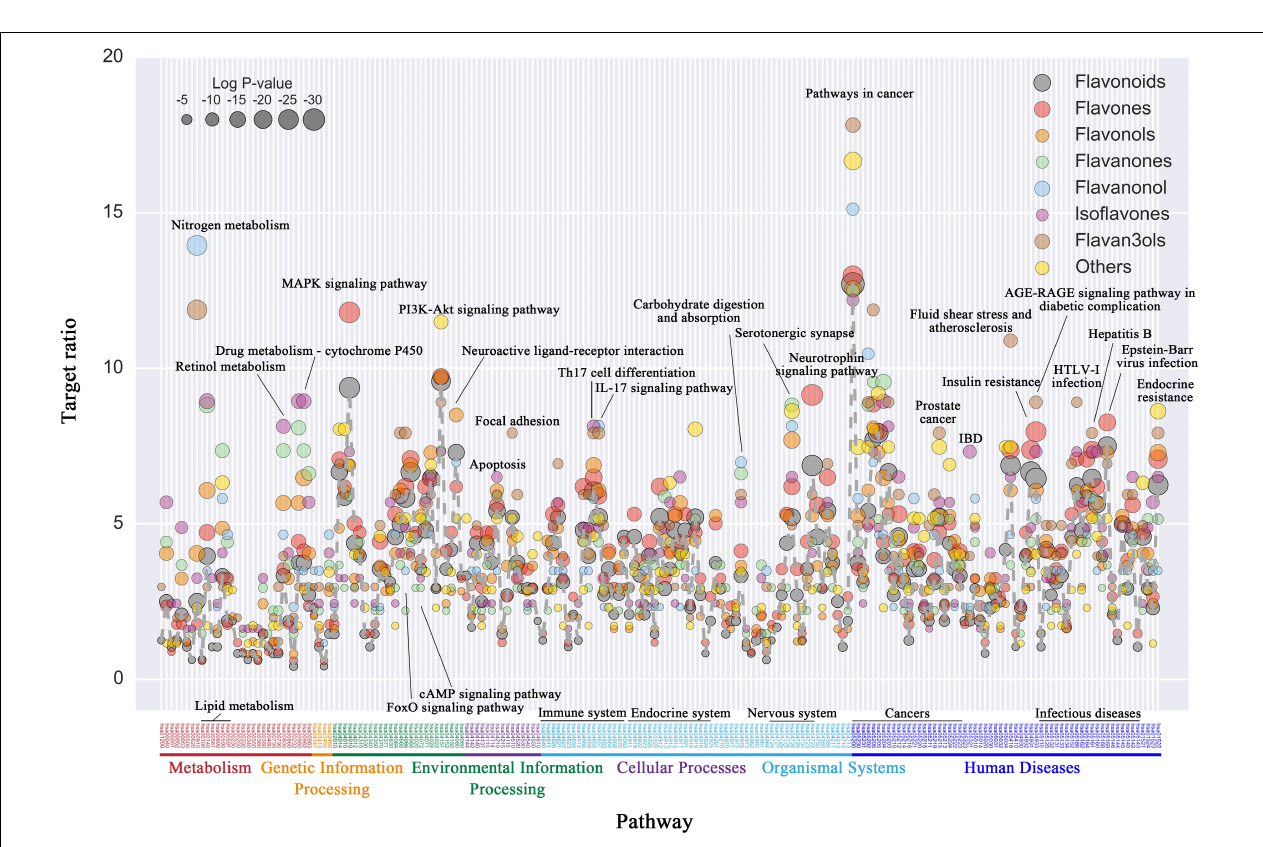
FIGURE 2 | KEGG pathway enrichment analysis of natural flavonoid products’ targets. Here, X -axis represents the enriched pathways ( p -value < 0.05), which were categorized according to KEGG classification. Y -axis represents target proportion of flavonoids in each pathway (number of flavonoids’ target in pathway/total number of flavonoids’ targets), the size of each nodes represents the significance of enrichment level (–LogP). Flavonoids and all six subclasses were marked in different colors.